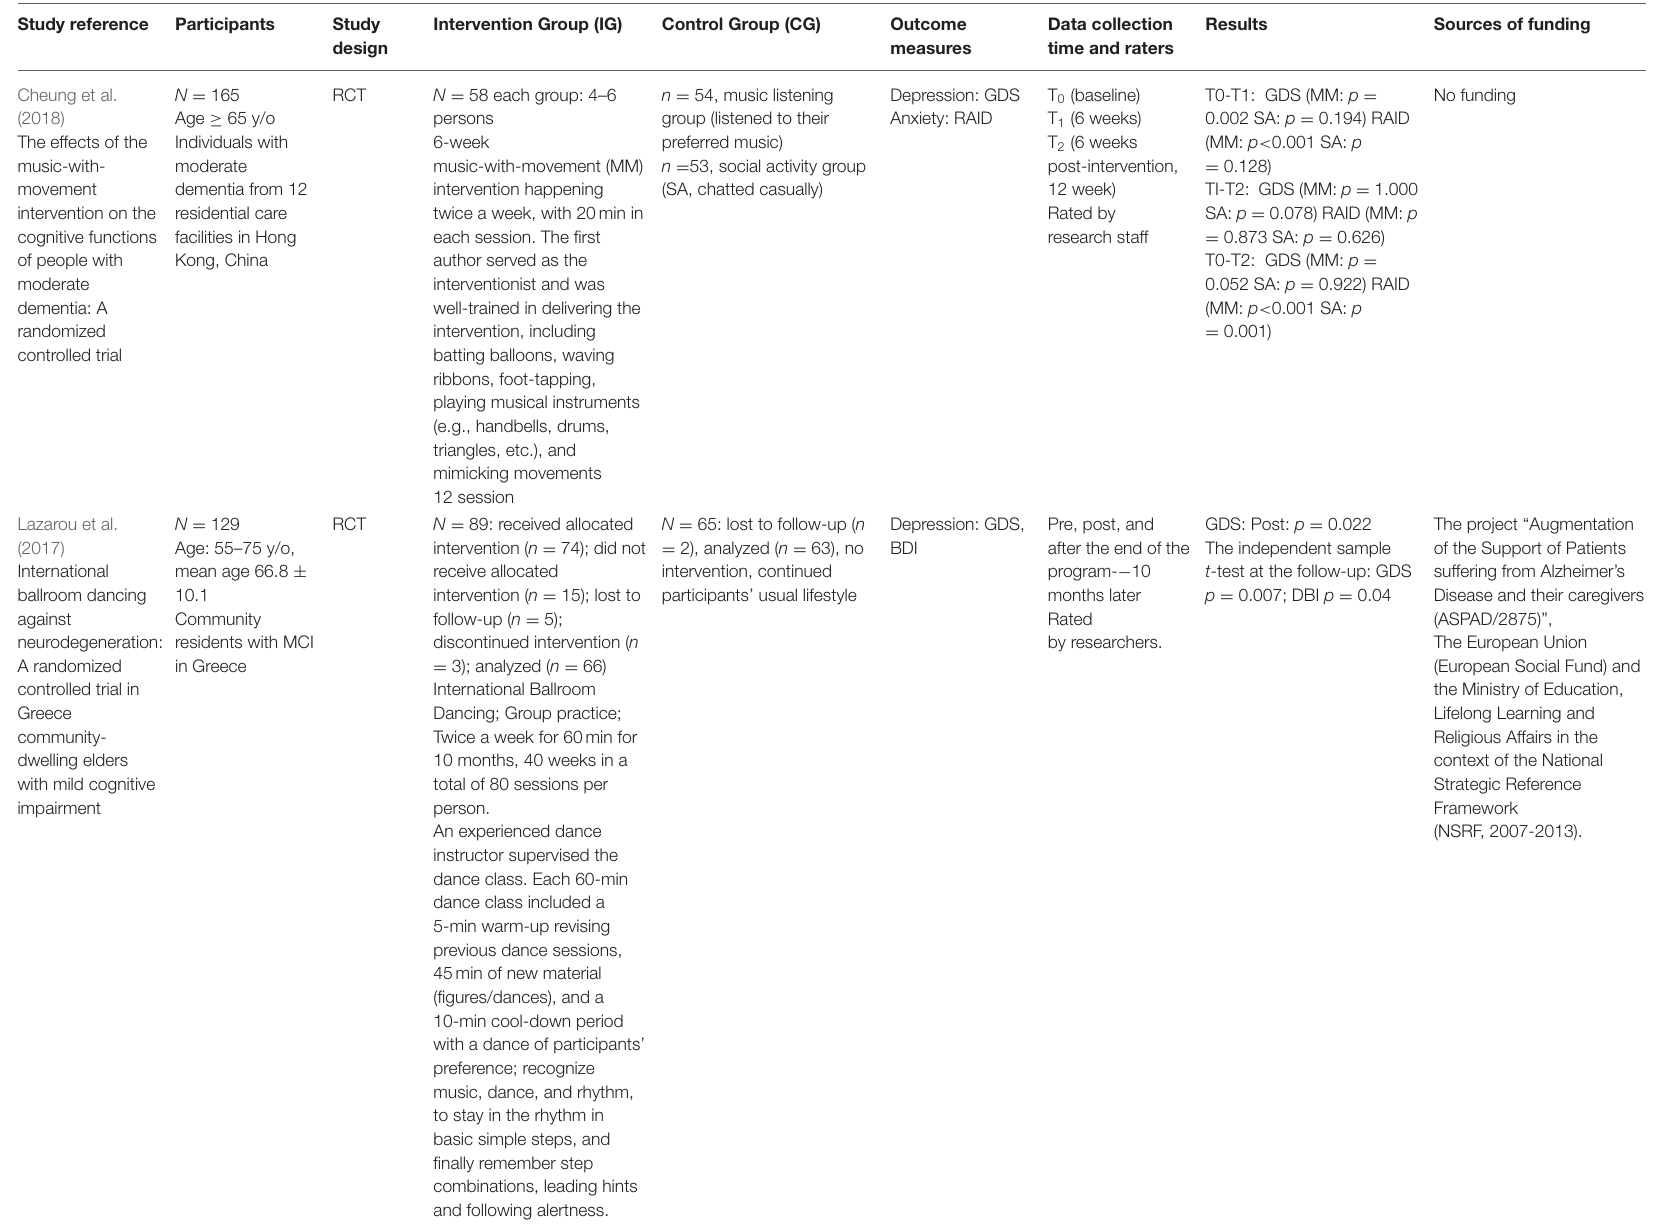
TABLE 2 | Characteristics of included